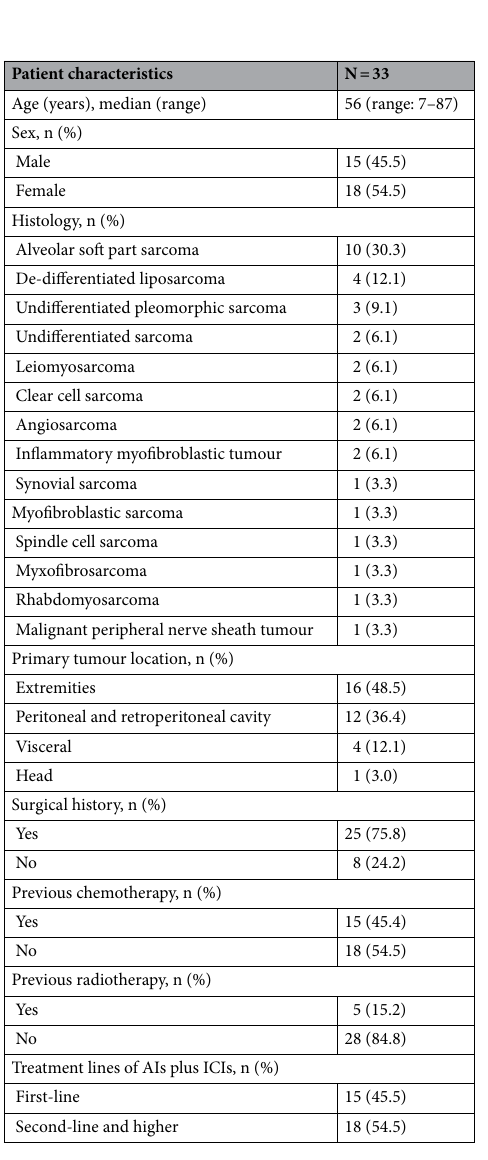
Table 1. Baseline characteristics. AIs Angiogenesis inhibitors, ICIs Immune checkpoint